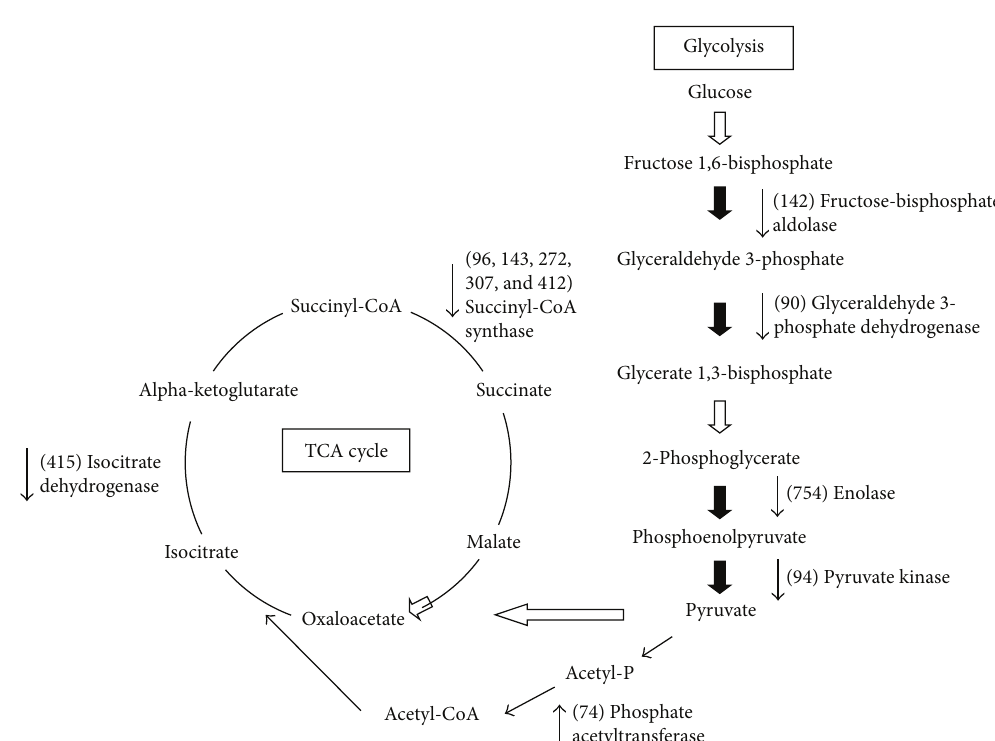
Figure1:Identifiedspotsonthe2DproteomemapofSAEandWT.SAEandWTweregrowninTSBmediumat37 ∘ Cuntilthepostexponential growth phase; the bacteria were then separated by centrifugation. Bacteria cell pellets were dissolved in lysis buffer and sonicated on ice. The 2-DE gels were performed using 24 cm immobilized dry strips (IPG, nonlinear, pH 4–7, GE Healthcare) and analyzed by ImageMaster 2D platinum 6.0 software (Amersham Biosciences). Differentially expressed protein spots on 2-DE gels were identified by MS/MS analysis and shown in gels with unique protein spot numbers. Protein spots were identified using a 4700 MALDI-TOF/TOF Proteomics Analyzer (Applied Biosystems, California, USA).